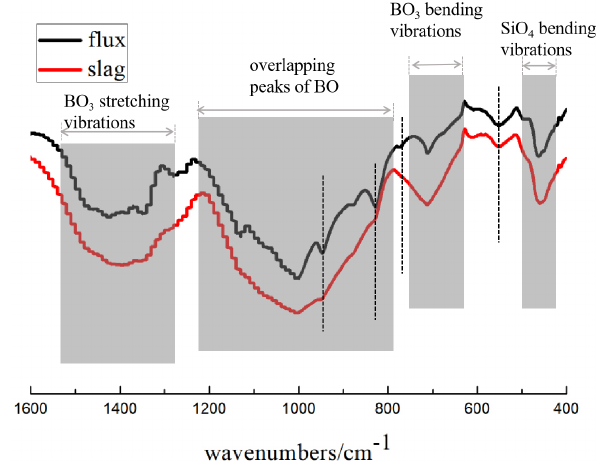
Figure 5: FTIR spectra of flux and